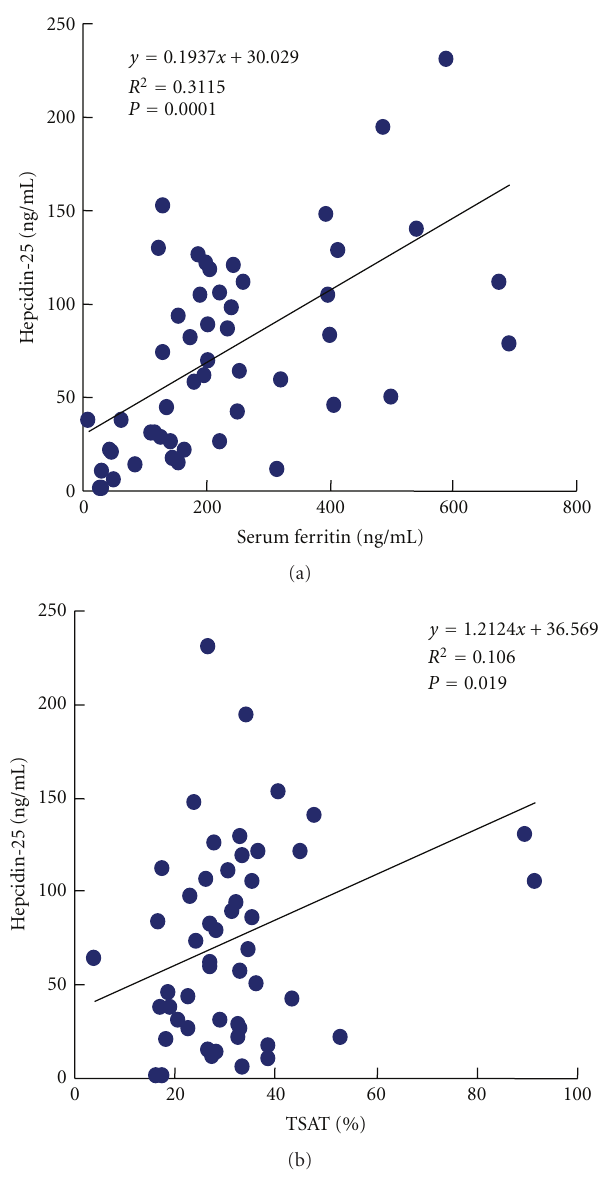
Figure 3: Correlation between serum hepcidin-25 levels and iron parameters. (a) Hepcidin and serum ferritin. (b) Hepcidin and TSAT.